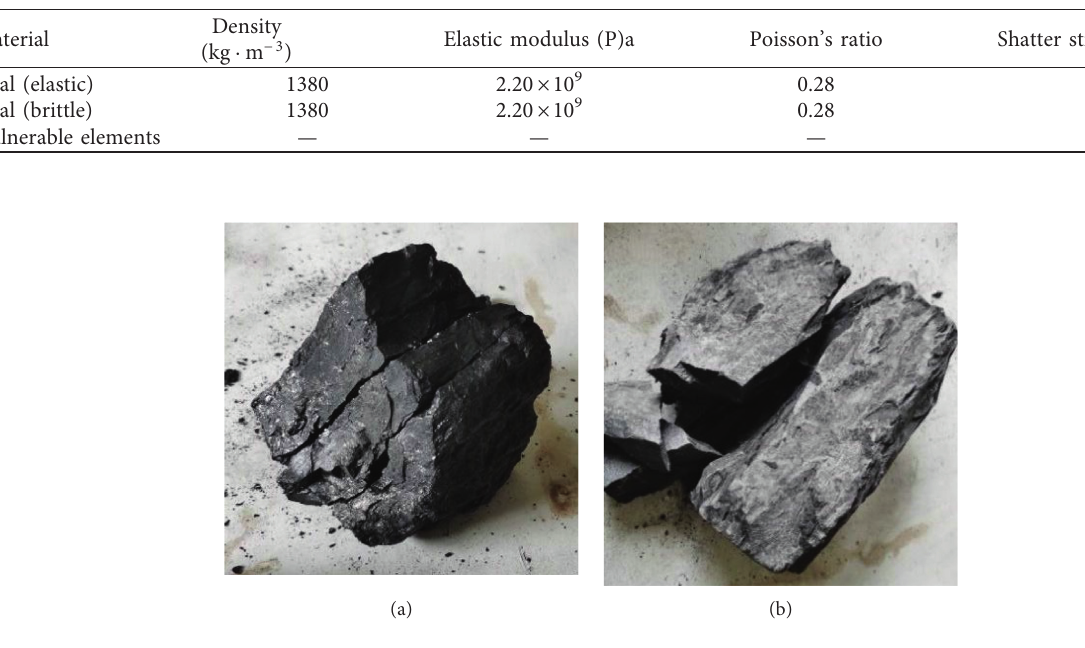
Table 2: Main material properties in particle model.